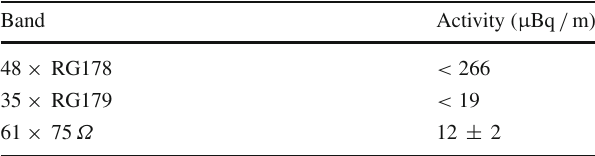
Table 4 Results from Radon emanation measurements of the woven cable bands (see Table 3) Band